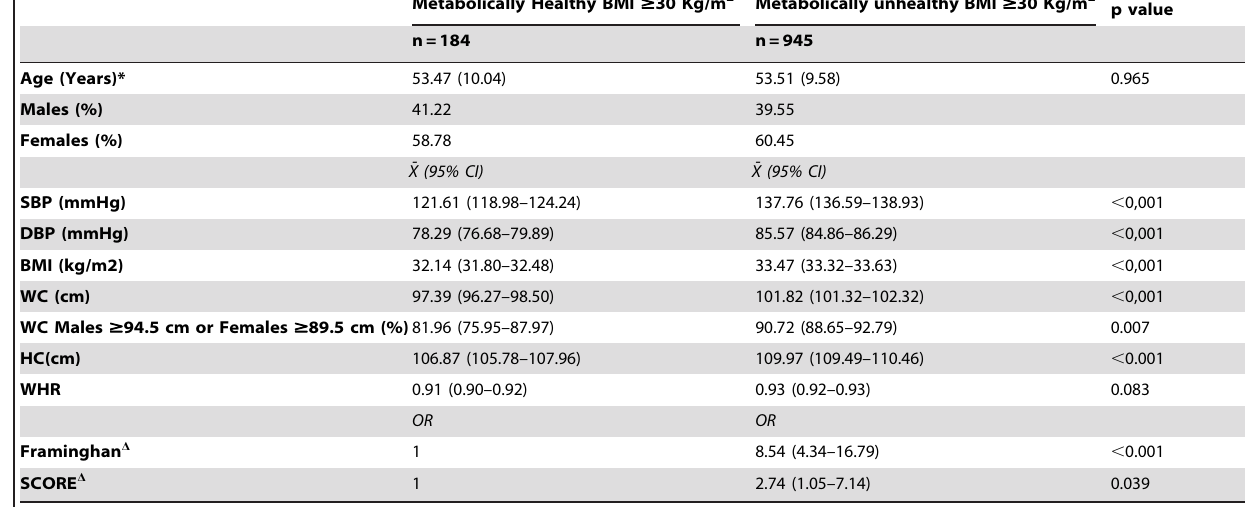
Table 3. Basic characteristics and anthropometric parameters in individuals with BMI $ 30 Kg/m 2 by Wildman modified criteria, means adjustment by age and